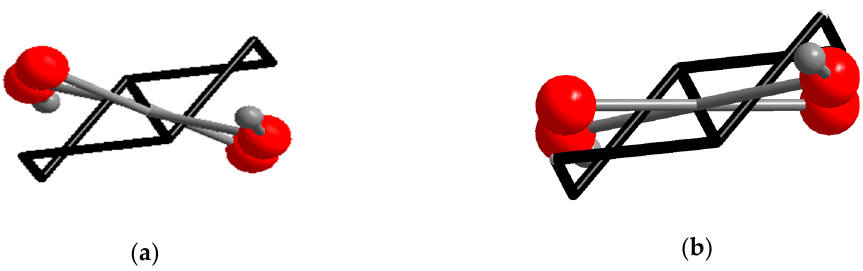
Figure A2. Conformations of H 2 chdc molecule in 6 ( a ) and in previously reported polymorph ( b ).